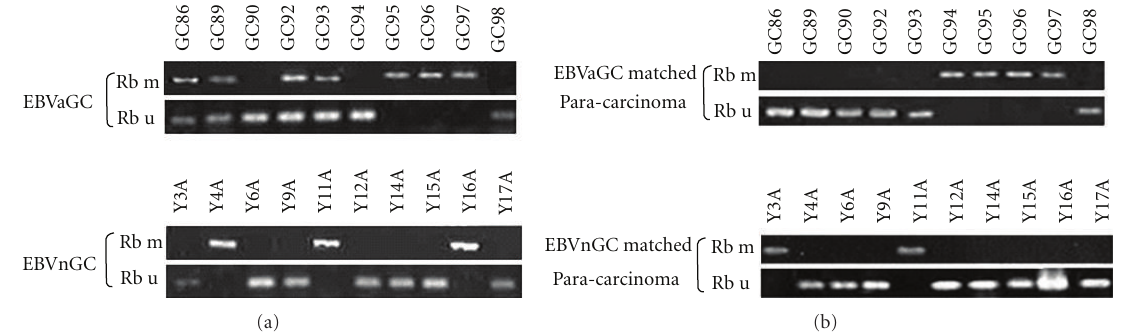
Figure 1: RB promoter methylation in EBVaGC, EBVnGC, and matched paracarcinoma tissues. (a) Representative RB promoter methylation in EBVaGC and EBVnGC by MSP. U, PCR product from the MSP assay using primers specific for the unmethylated allele; M, PCR product from the MSP assay using primers specific for the methylated allele. (b) Representative RB MSP assay results for matched paracarcinoma tissues.